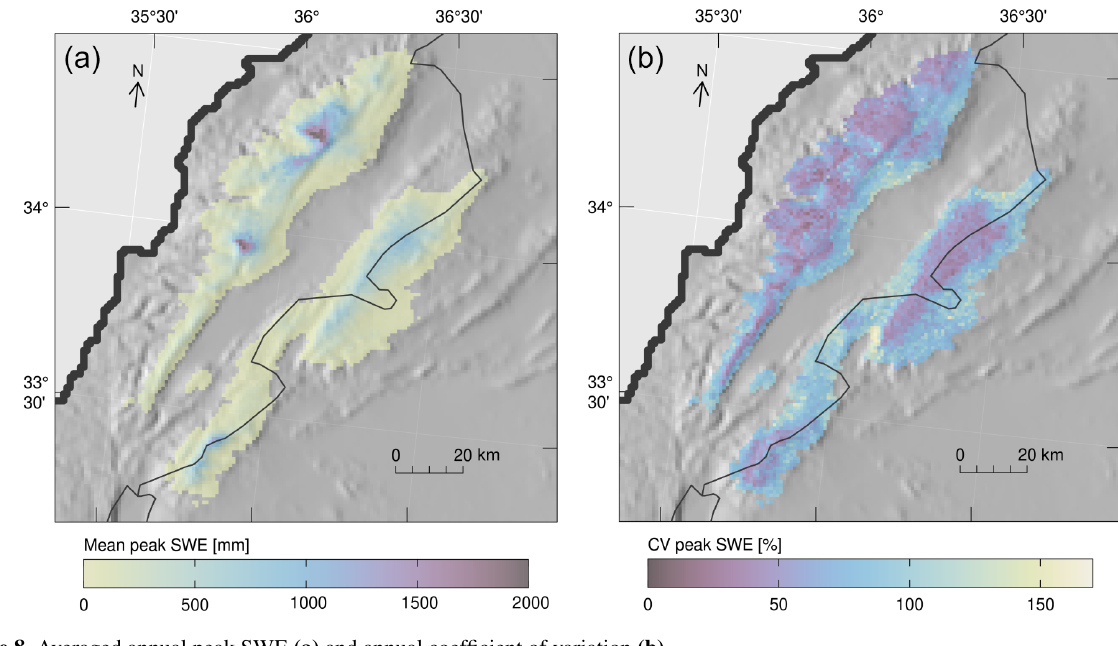
Figure 8. Averaged annual peak SWE (a) and annual coefficient of variation (b) .